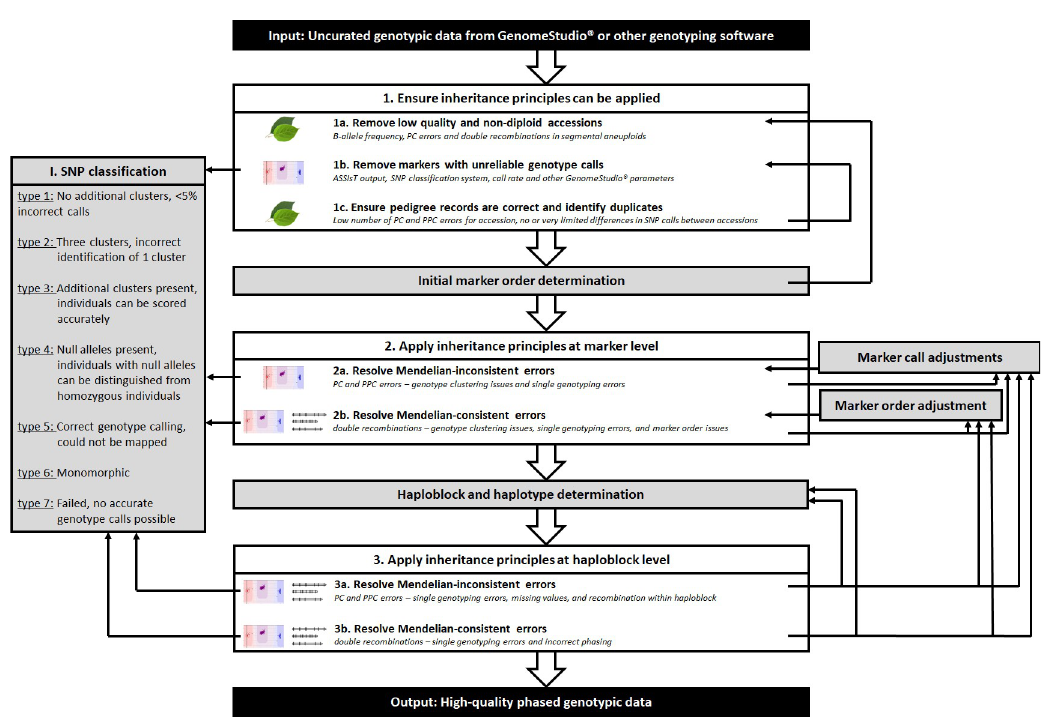
Fig 1. Steps of the high-resolution genotypic data curation workflow to ensure a quick and efficient curation process. Steps that identify errors are shown in white boxes; procedures needed for detecting, keeping track of, and resolving errors but do not identify errors directly are in grey boxes. After obtaining a first set of genotypic data, initial steps ensure that inheritance principles can be readily applied by removing individuals and markers that do not follow these principles and by ensuring pedigree records are correct. In the next set of steps, inheritance principles are applied at the individual marker level. In the final set of steps, these principles are applied at the haploblock level. Output used to detect and resolve observed errors at each step are given in italics. The leaf symbol indicates errors at the level of individual; the intensity plots symbol indicates errors at the level of SNP scoring; the genetic map symbol indicates errors at the level of genetically linked markers and phased alleles. When applying inheritance principles in parts 2 and 3, alleles that do not occur in an individual’s parents (‘Mendelian-inconsistent errors’) are first resolved before addressing remaining genotyping errors (‘Mendelian-consistent errors’). Several procedures, such as marker call adjustments and map order adjustments, are performed throughout the steps of the workflow to resolve errors detected. Each time after performing these common procedures, specific steps of the workflow must be repeated, forming an iterative process that ends when all errors are